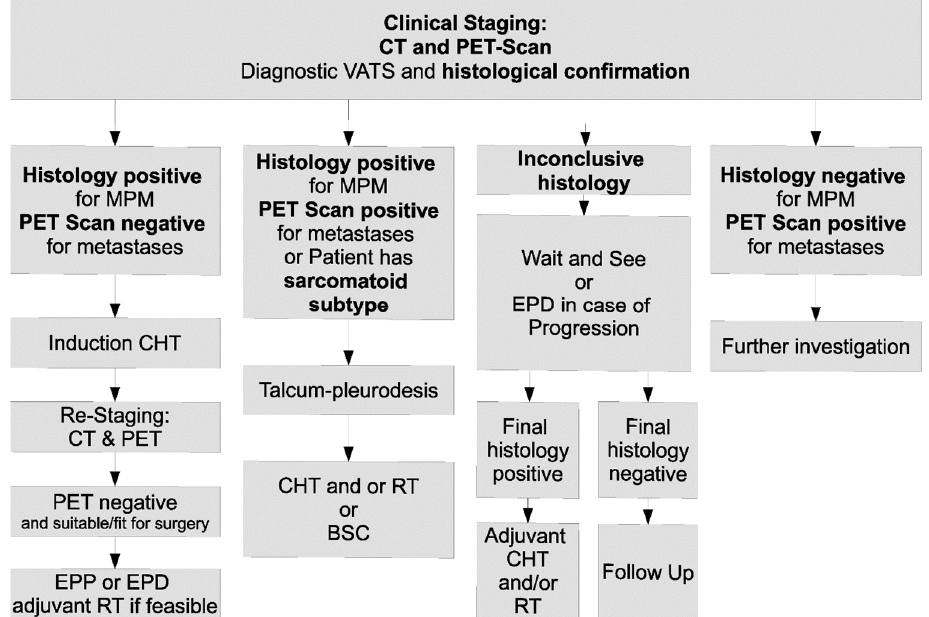
Figure 1. Algorithm of the treatment approach used in our institution. BSC best supportive care, CHT chemotherapy, CT computed tomography, EPD extended pleurectomy/decortication, EPP extrapleural pneumonectomy, MPM malignant pleural mesothelioma, PET positron emission tomography Scan, RT radiotherapy.